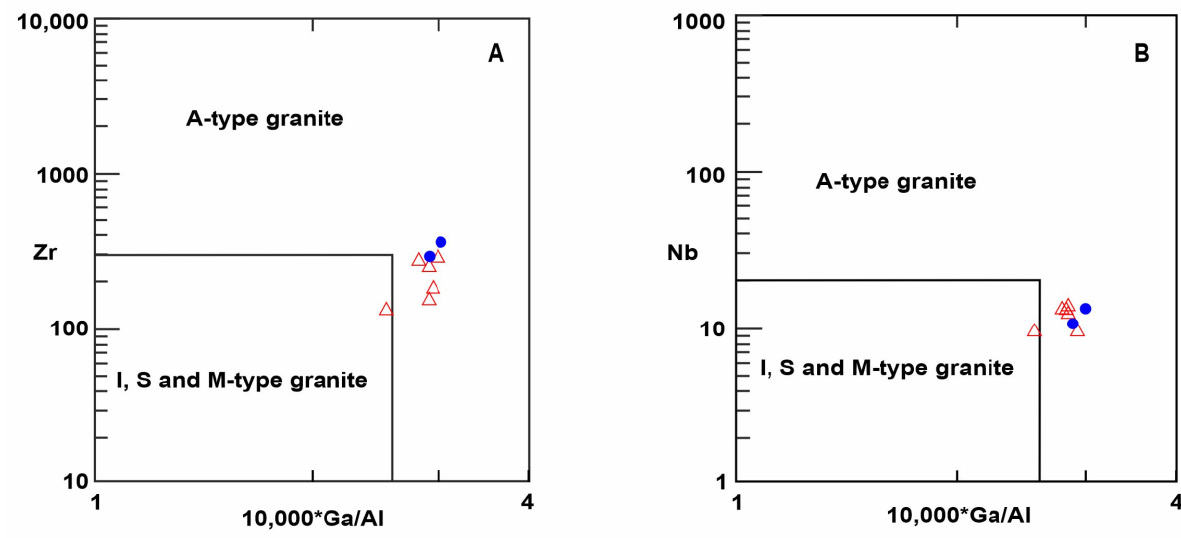
Figure 6. Discrimination diagrams of granites. ( A ) Zr versus 10,000 Ga/Al and ( B ) Nb versus 10,000 Ga/Al diagrams of Whalen et al. [27] in which the Wadhrai analyses plot in the A-type granite field in both these diagrams.